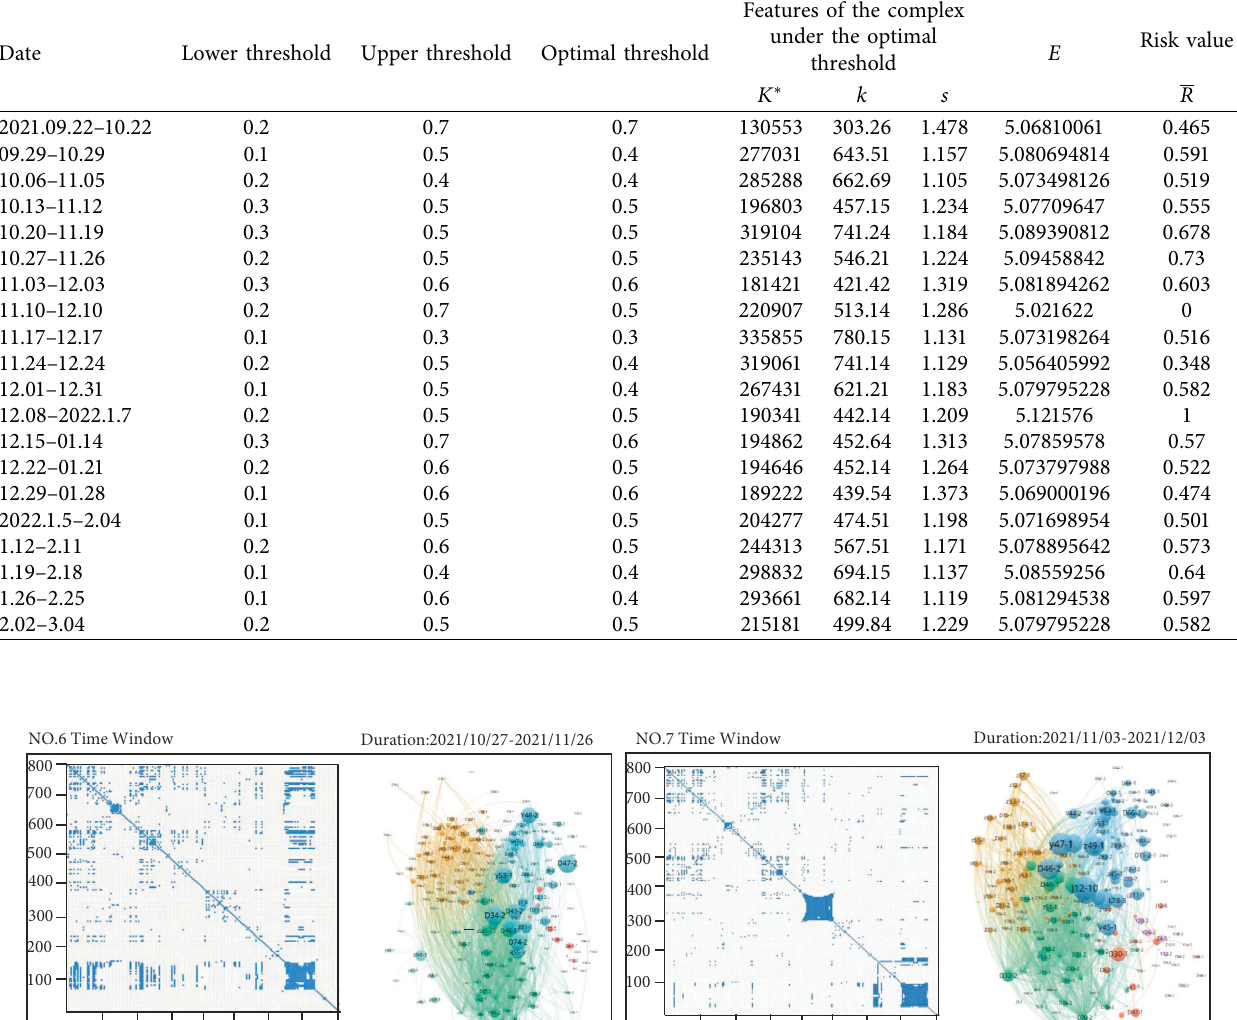
Table 5: Optimal thresholds and complex network features for each time window.